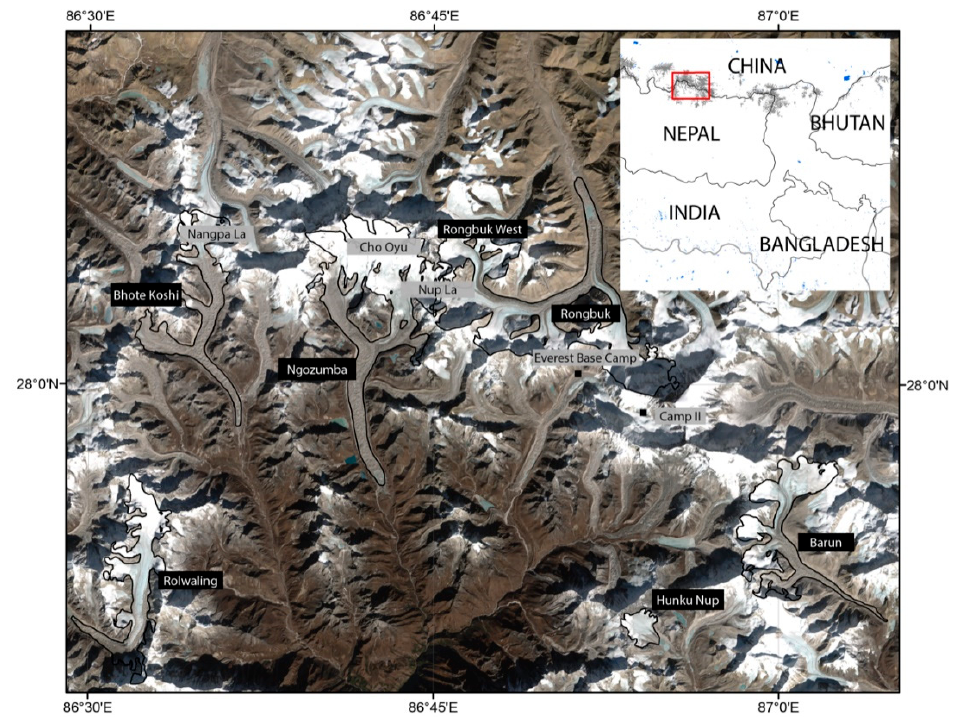
Figure 1. Field area indicating glaciers observed, weather stations, and landmarks labeled on a